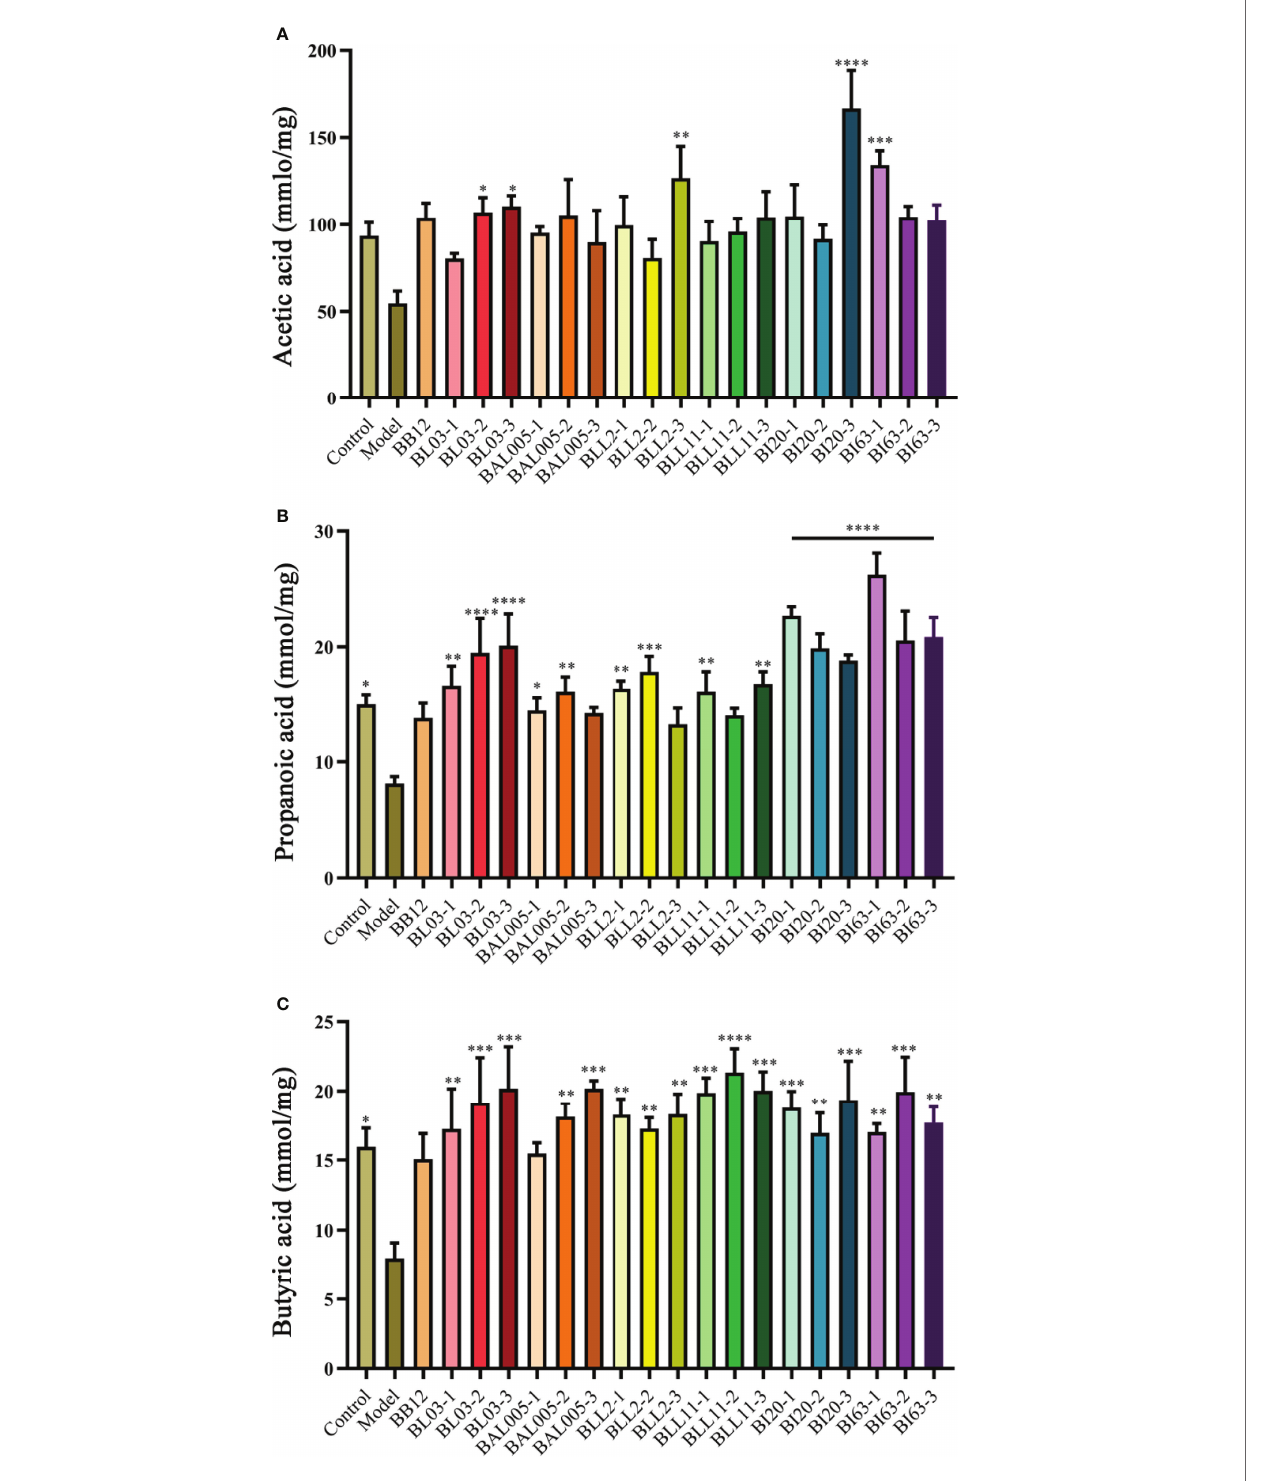
FIGURE 4 | The levels of SCFAs in mice feces. Acetic acid (A) . Propionic acid (B) . Butyric acid (C) . There is a signi fi cant difference between the bacterial intervention group and the model group, where * means P < 0.05, **P < 0.01, ***P < 0.005, ****P <